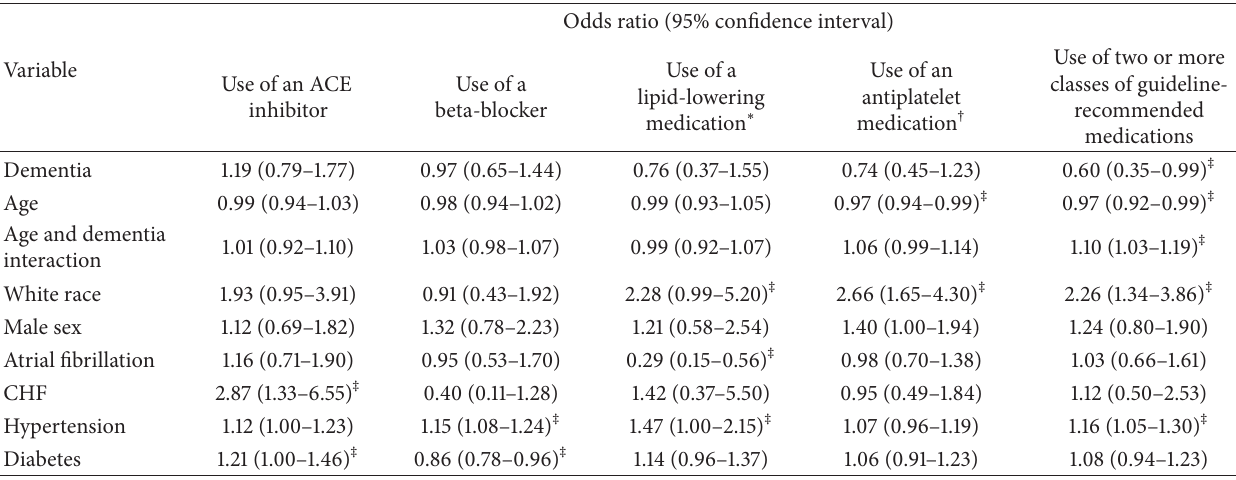
Table 3: Association between dementia and use of one or more classes of guideline-recommended medications for secondary prevention of ischemic heart disease by study participants, 1989 to